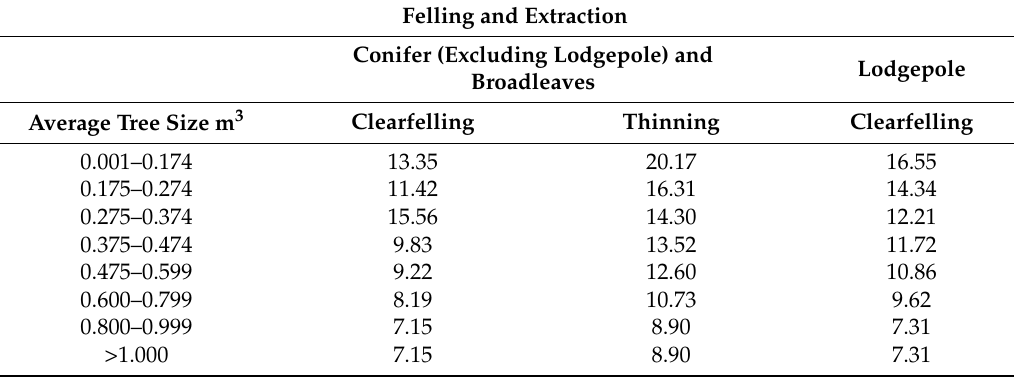
Table A3. Felling and extraction costs (in € m − 3 ) used in the model, based on average tree size, harvesting operation and species. Source: